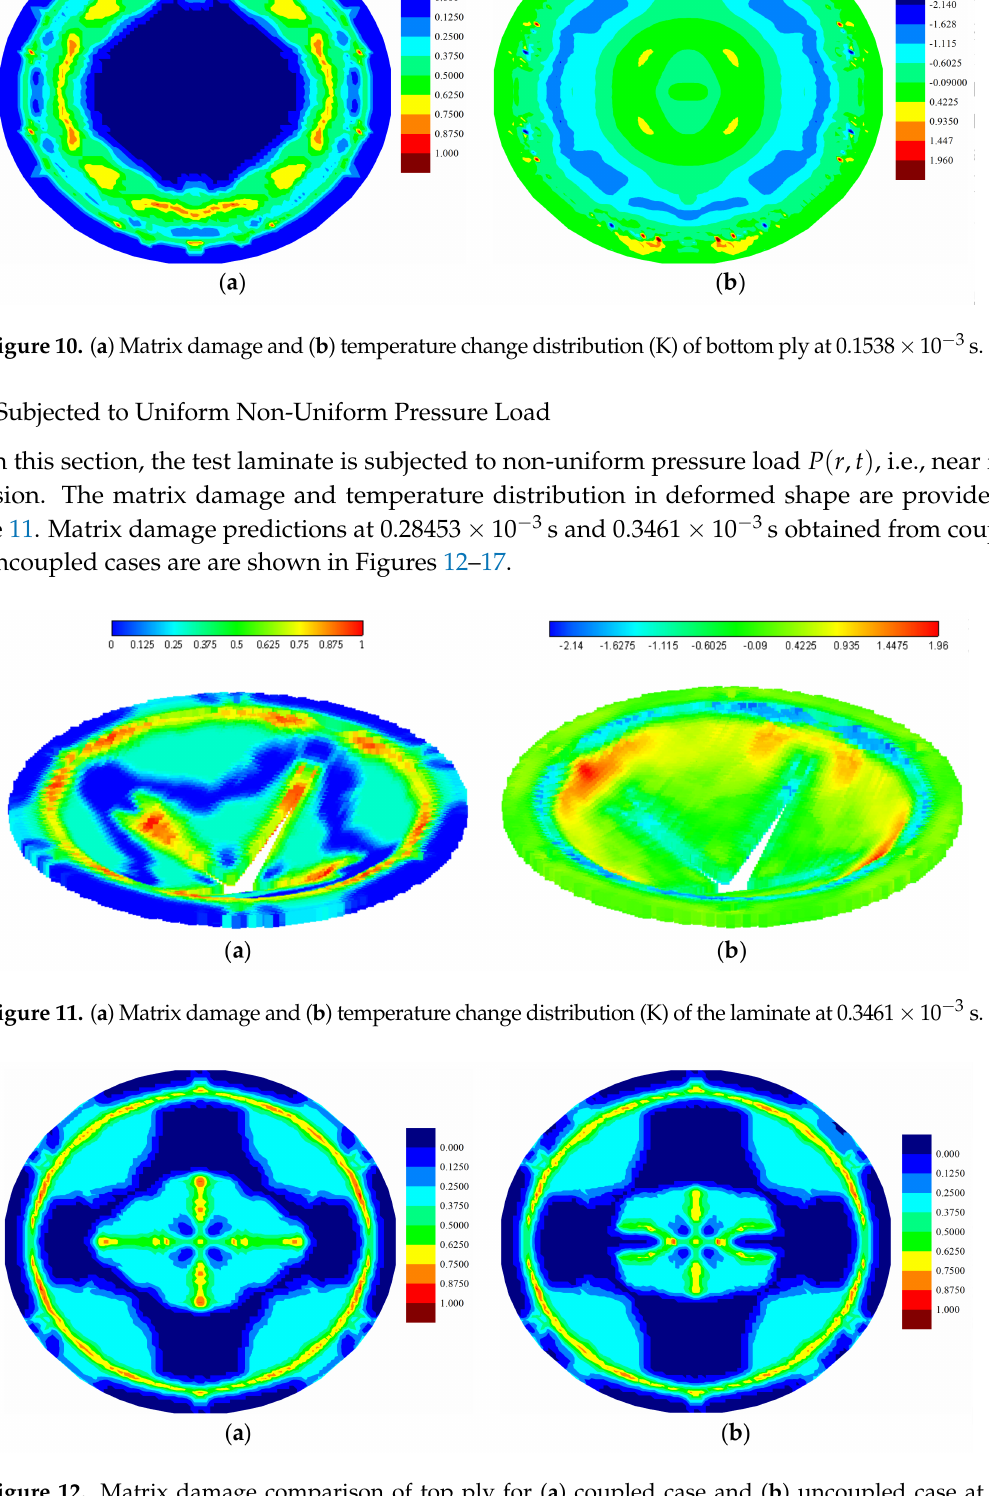
Figure 12. Matrix damage comparison of top ply for ( a ) coupled case and ( b ) uncoupled case at 0.28453 × 10 − 3